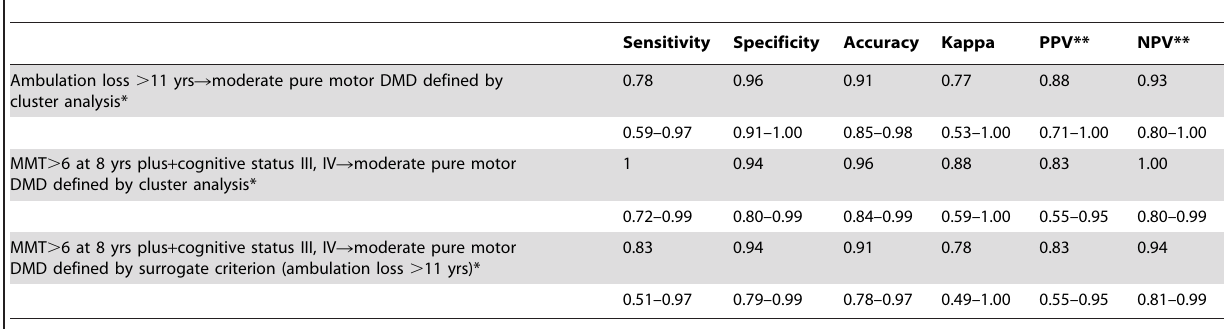
Table 4. Simplified indicators of moderate pure motor DMD (cluster C) derived from series 1.